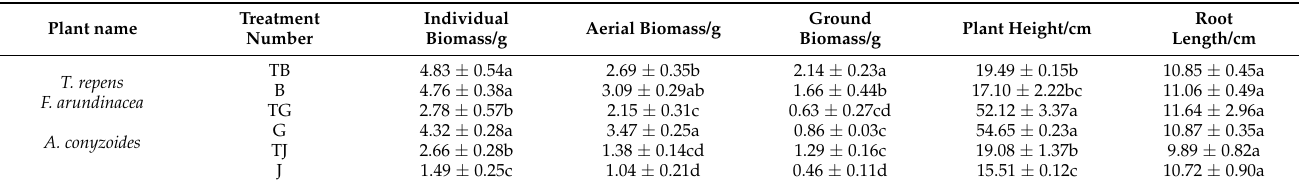
Table 4. Growth index of Cr-tolerant garden